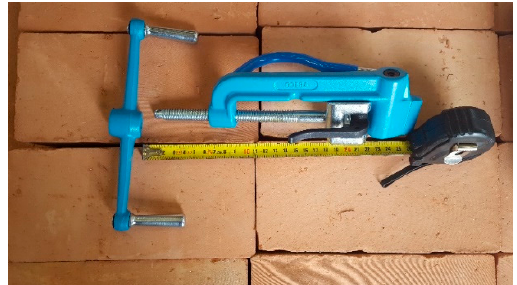
Figure 37. Manual strapping tool for steel.